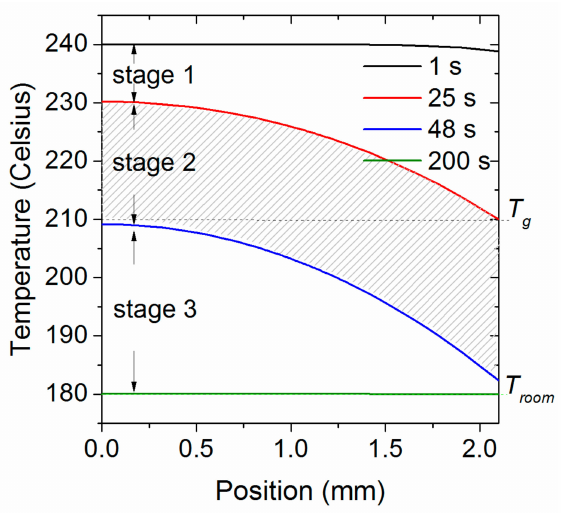
Figure A1. Temperature-versus-position curves of fast cooling rate case at four different times also divided the whole process into three stages.